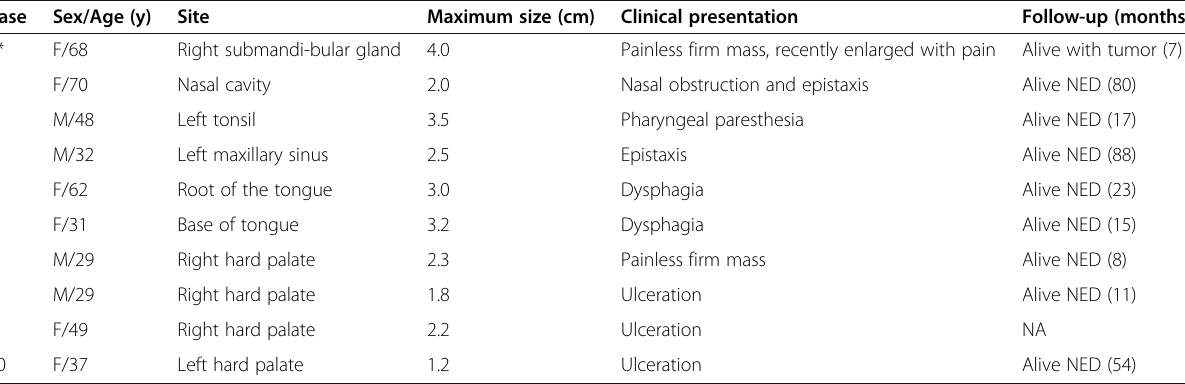
Table 1 Clinicopathological data for 10